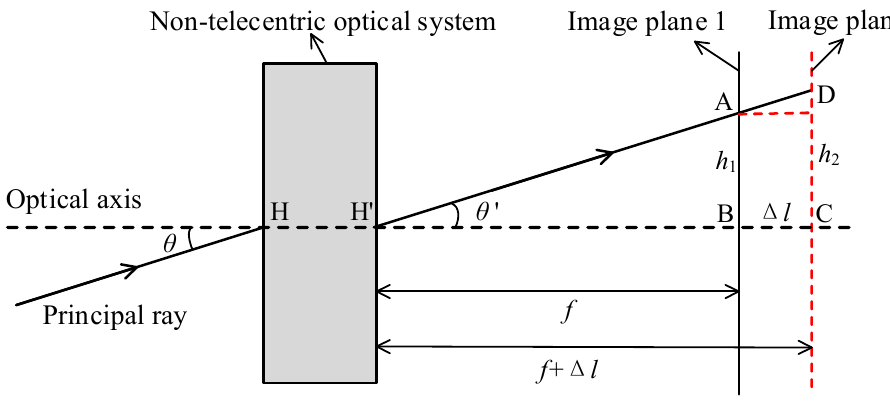
Figure 3. Imaging principle diagram of the non-telecentric optical system. Figure 3 illustrates that the range of image height is ∆ h (cid:48) when the optical system is focused on the same FOV θ . Consequently, when the previous calibration parameters are used for image stitching, the stitched images will be misaligned after focusing. To avoid the mismatch, two approaches can be used; the first approach is to re-calibrate after each focus, which is very restricted in practical implementation. The second approach is to design the optical system in such a way that the following Equation (10) θ (cid:48) = 0. The imaging principle diagram of a non-telecentric optical system is illustrated in Figure